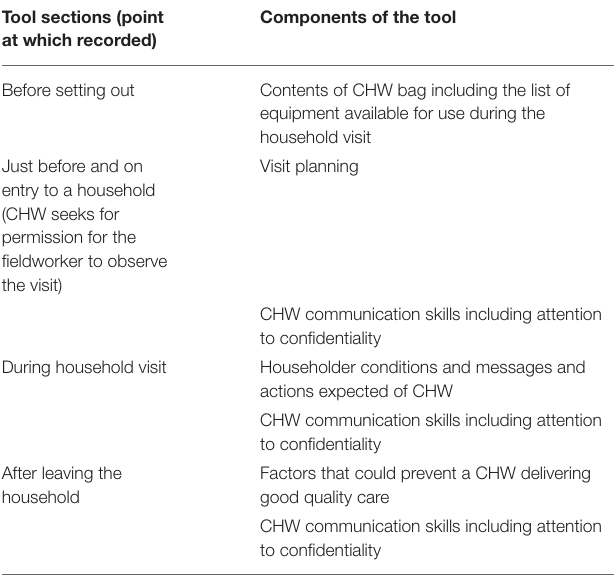
TABLE 1 | The quality-of-care assessment tool